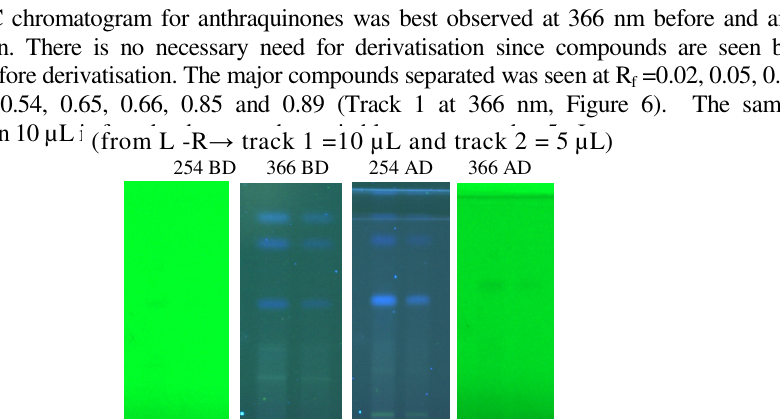
Figure 5 . (Plate no 5 ) HPTLC of essential oil, coumarin, phenol and carboxlic Anthraquinones